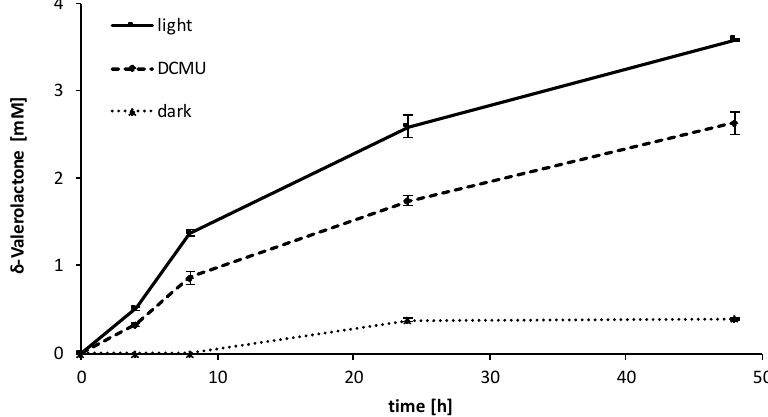
Figure 2. Biotransformation of cyclopentanone 1f (5 mM) by cells of Synechocystis sp. PCC6803 harbouring CHMO under light of 300 µ E m − 2 (solid line), under light in presence of the inhibitor DCMU (dashed line) and under darkness (pointed line).